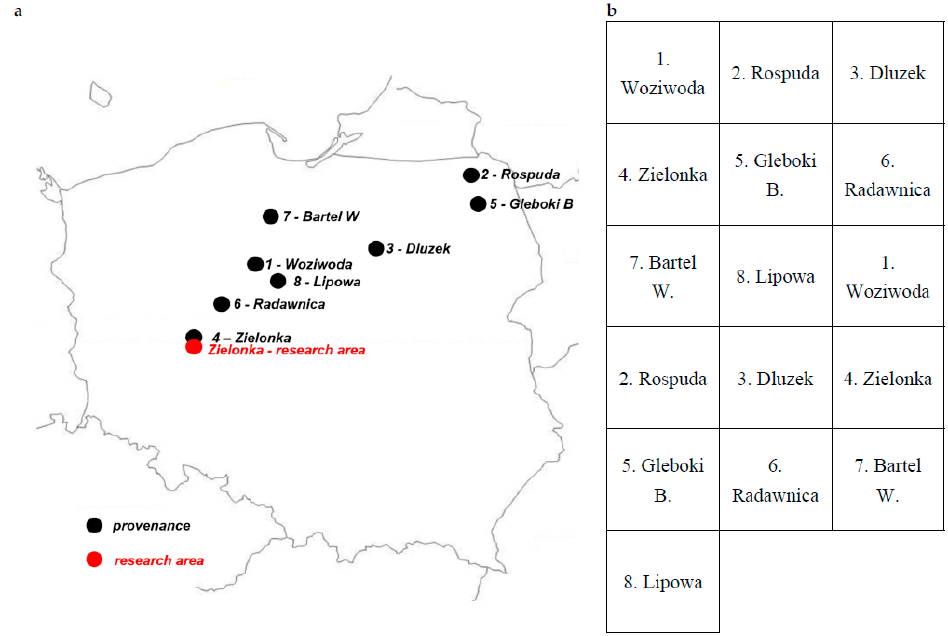
Figure 1. ( a ) Locations of native Scots pine stands used for the provenance study and research area; ( b ) Distribution of research plots with pine provinces in the Zielonka research plot. The experimental plot consisted of 16 lots of 1400 m 2 each. Each of the eight provenances was distributed at random over two lots. The lots were of the same dimensions, and over 1000 1-year-old pine seedlings were planted. The initial cultivation spacing was 1.4 × 0.5 m. The experimental plot consisted of even-aged pine monocultures, which were distinguished by intense interindividual competition.